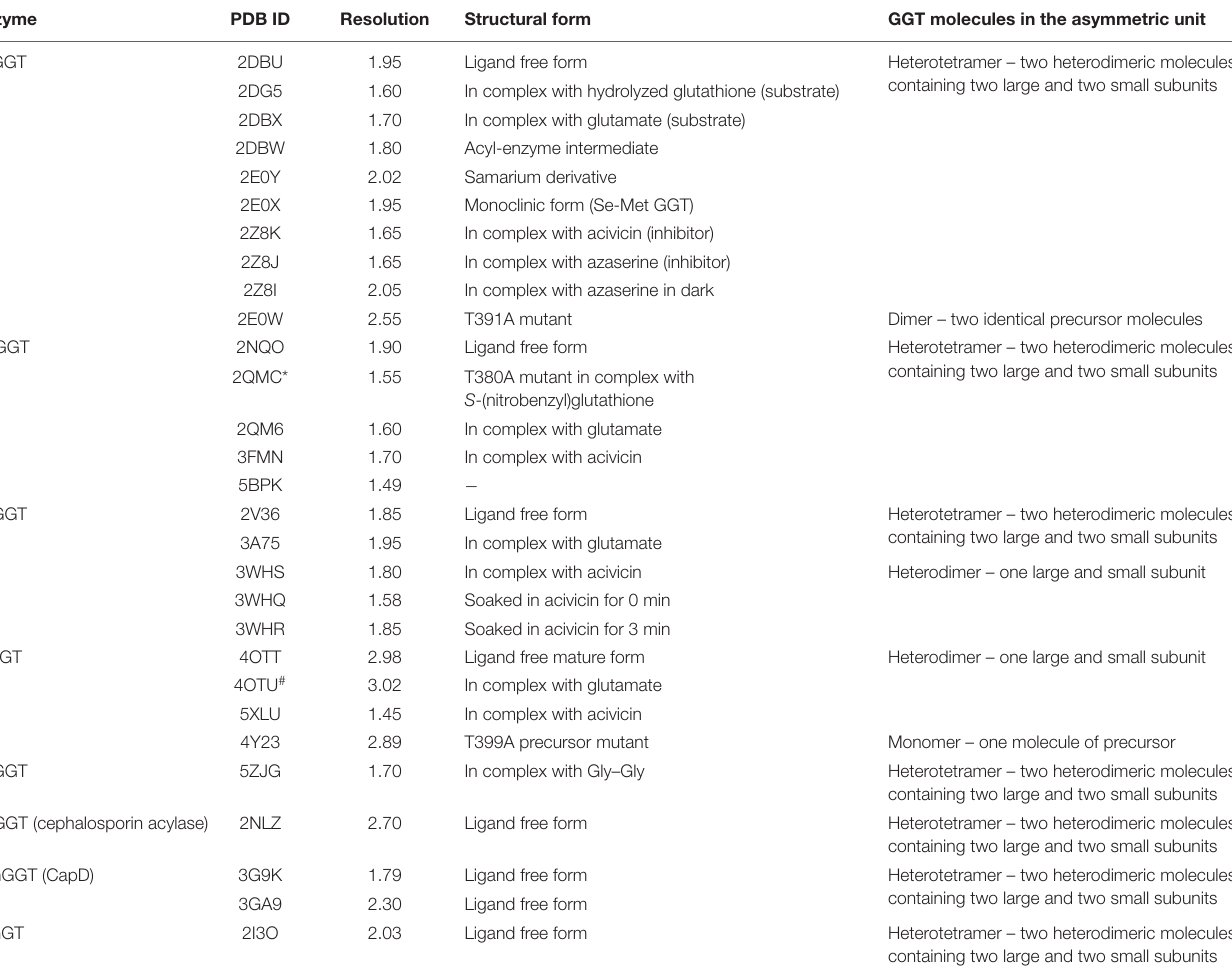
TABLE 2 | List of crystal structures available for prokaryotic gamma-glutamyl transpeptidase (GGTs). Enzyme PDB